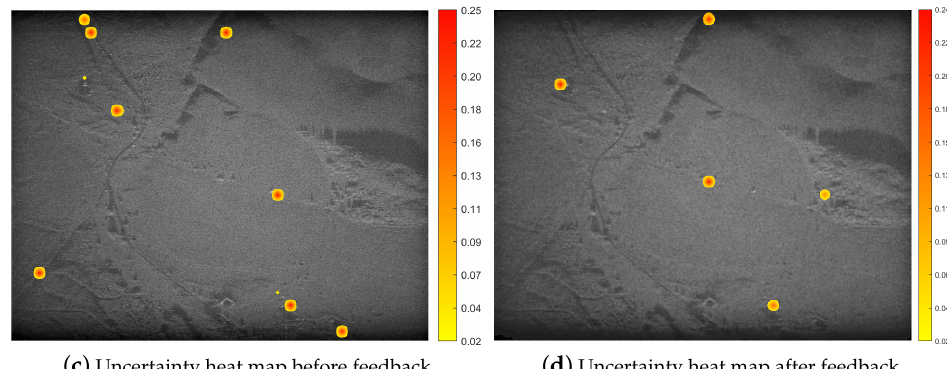
( c ) Uncertainty heat map before feedback. ( d ) Uncertainty heat map after feedback. Figure 12. Comparison of the effect of partial retraining BCNN on confident incorrect detections for scene 3. The main takeaway from ( a , b ) is the reduction of false detections in the center of the scene over the hill areas. From ( c , d ) there is an reduction in the number of high uncertainty areas.